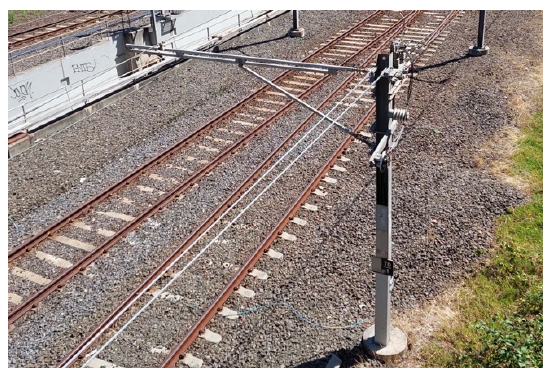
Figure 3. Single mast OWS.